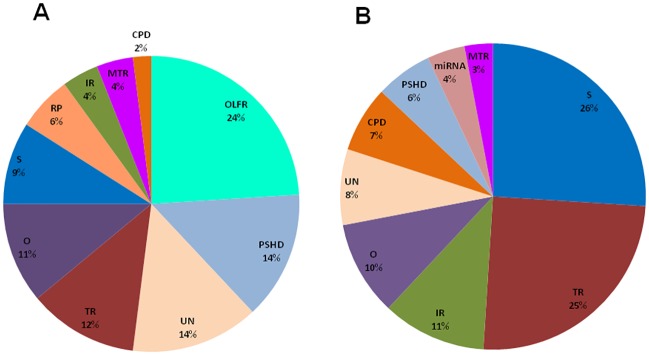
Distribution of ouabain-sensitive genes detected in cerebellum granule cells and listed in Tables 4–7 among major functional categories.Cells were incubated in the presence of 100 nM (A) or 1 mM ouabain (B) for 3 h. Functional categories: CPD—cell proliferation and death; IR—immune and inflammatory responses; miRNA—microRNAs; MTR—membrane transporters; O—others; OLFR—olfactory receptors; PSHD—protein, synthesis, holding, and degradation; RP—ribosomal proteins; S—signaling; TR—transcription regulation; UN—uncharacterized.